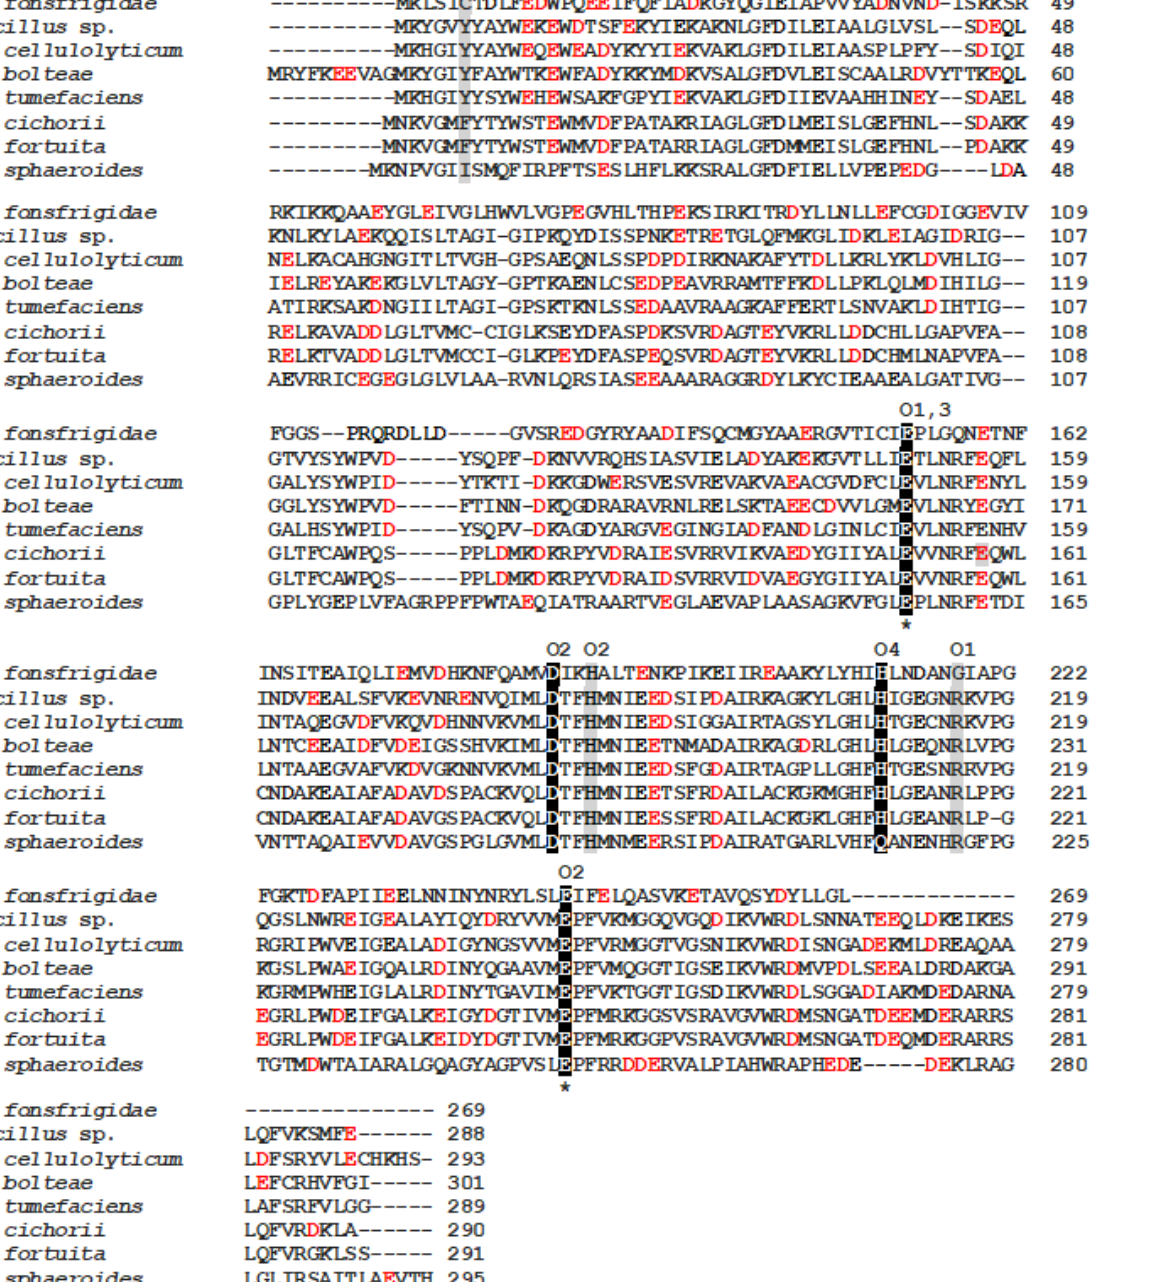
Figure 1. Amino acid sequence alignment of IfDPEase compared to other ketose 3-epimerase mem- bers. The substrate-binding subsite residues are shown in gray, the metal-coordinating site residues are marked in black, and the catalytic site residue is marked in black with an asterisk. Red letters represent acidic amino acids on the surface of ketose 3-epimerase structures. Sequence for DPEase from I. fonsfrigidae strain SP3-1 (GenBank accession no: OP035404) was aligned with those of DPEases from Bacillus sp. KCTC 13219 (KYG89858.1), C. cellulolyticum H10 (ACL75304), Clostridium bolteae (EDP19602), Agrobacterium tumefaciens (AAK88700.1); DTEases from P. cichorii (O50580) and Caballero- nia fortuita (WP_061137998.1); and DFEase from Rhodobacter sphaeroides (ACO59490.1). Alignment was constructed with ClustalW program https://www.ebi.ac.uk/Tools/msa/clustalo/ (accessed on 10 September